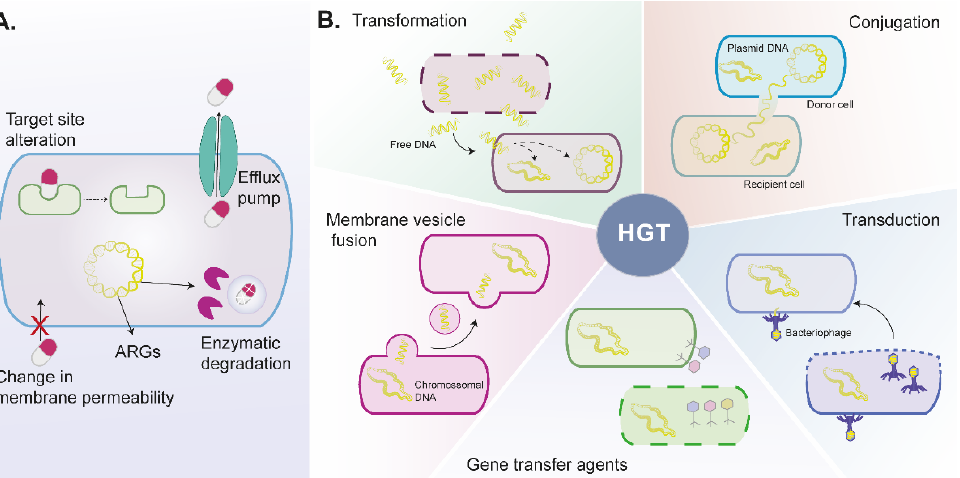
Figure 1. Schematic representation of antibiotic resistance mechanisms in bacteria. ( A ). Bacteria might present or acquire mechanisms to disable antibiotics, including alterations on target site, decreased permeability that impairs antibiotics cellular uptake, expression of drug efflux pumps that remove antibiotics from cells, and production of enzymes that modify or degrade antibiotics. ( B ). Horizontal gene transfer allows the exchange of genetic information between the same or different species by transformation, conjugation, membrane vesicle fusion, transduction, and gene transfer agents mechanisms. ARGs—antibiotic resistance genes, HGT—horizontal gene transfer.